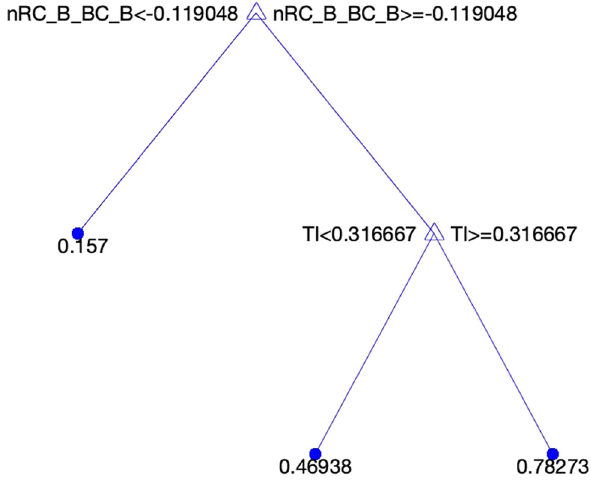
Figure 5: Boosted ensemble tree for trustor – the two retained vari - ables are the trustee ’ s commitment/joint control, / RC BC B B , and the TI.